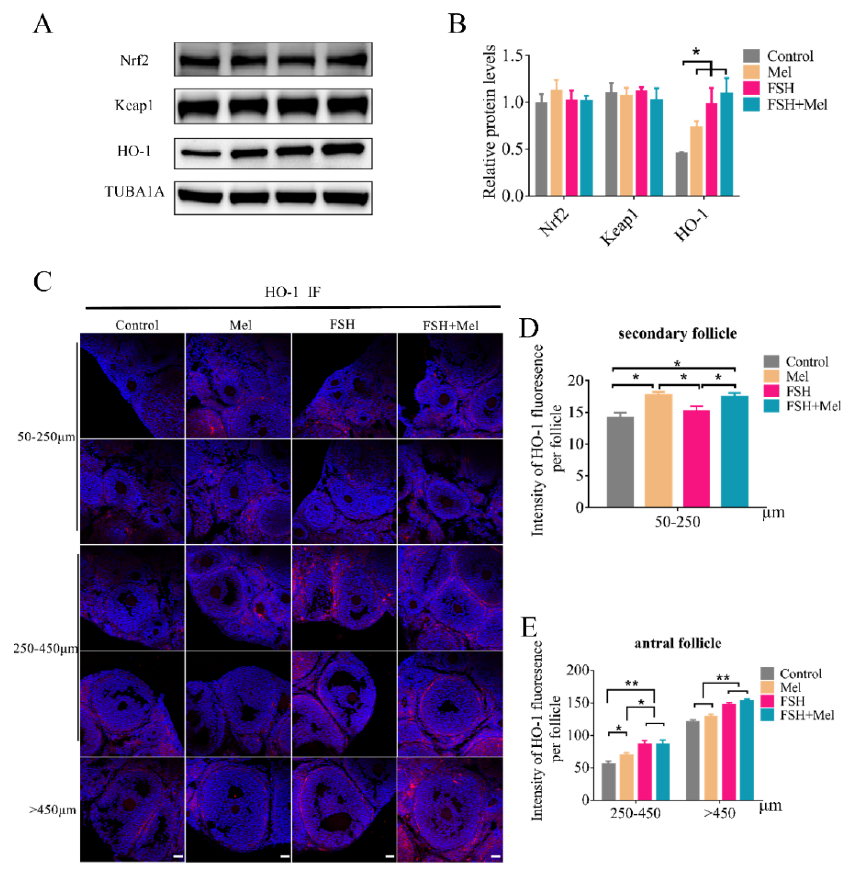
Figure 6. Effect of Mel and FSH on the expression of HO-1, Nrf2 and Keap1. ( A ) Western blotting detection of HO-1, Nrf2 and Keap1 protein expression level in ovary. ( B ) Quantification analysis of the HO-1, Nrf2 and Keap1 protein expression level. ( C ) Immunofluorescence (IF) detection of HO-1 expression level in follicles at all stages. ( D ) Quantification analysis of the HO-1 expression level in 50–250 µ m follicles. ( E ) Quantification analysis of the HO-1 expression level in 250–450 µ m and >450 µ m follicles. Horizontal bars denote treatments differing p < 0.05 *, p < 0.01